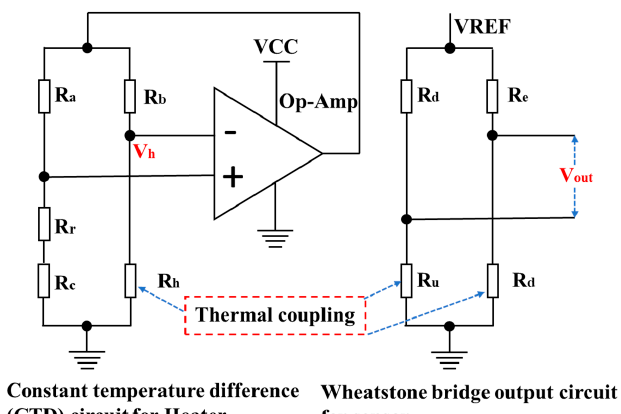
Figure 8. The constant temperature difference circuit and the Wheatstone bridge output circuit for the flow sensor.